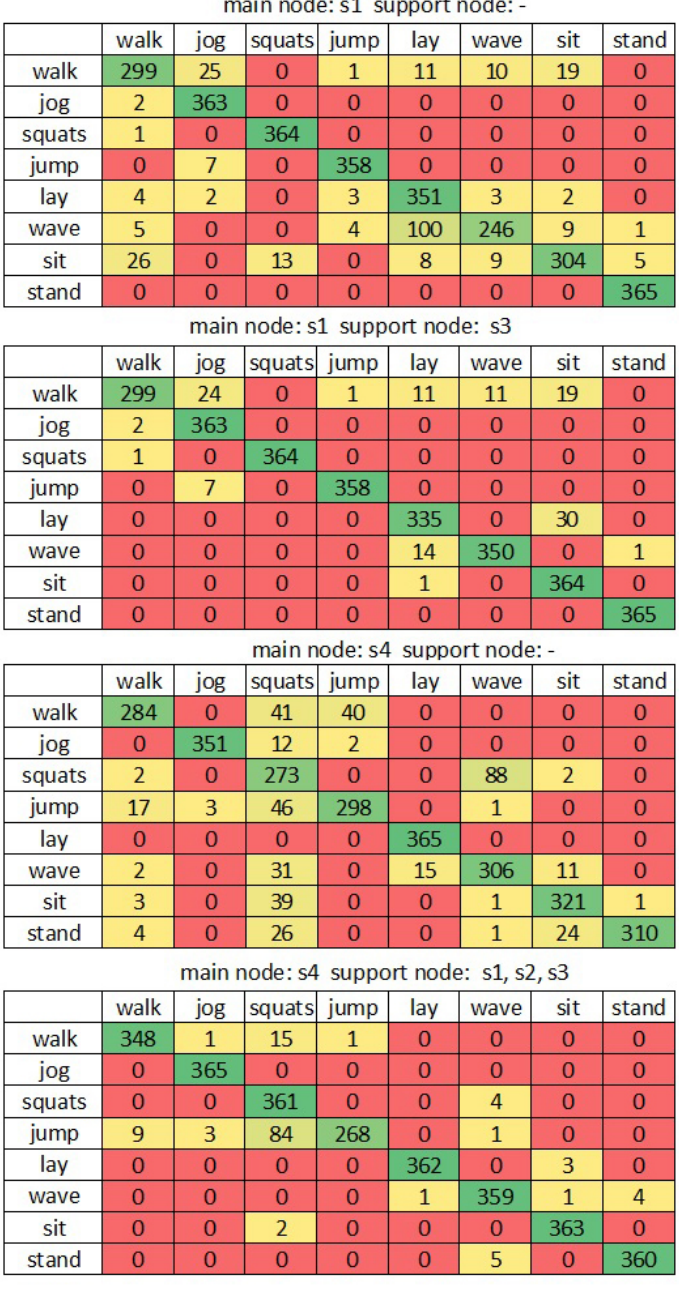
Figure 8. Confusion matrices for various sensor node